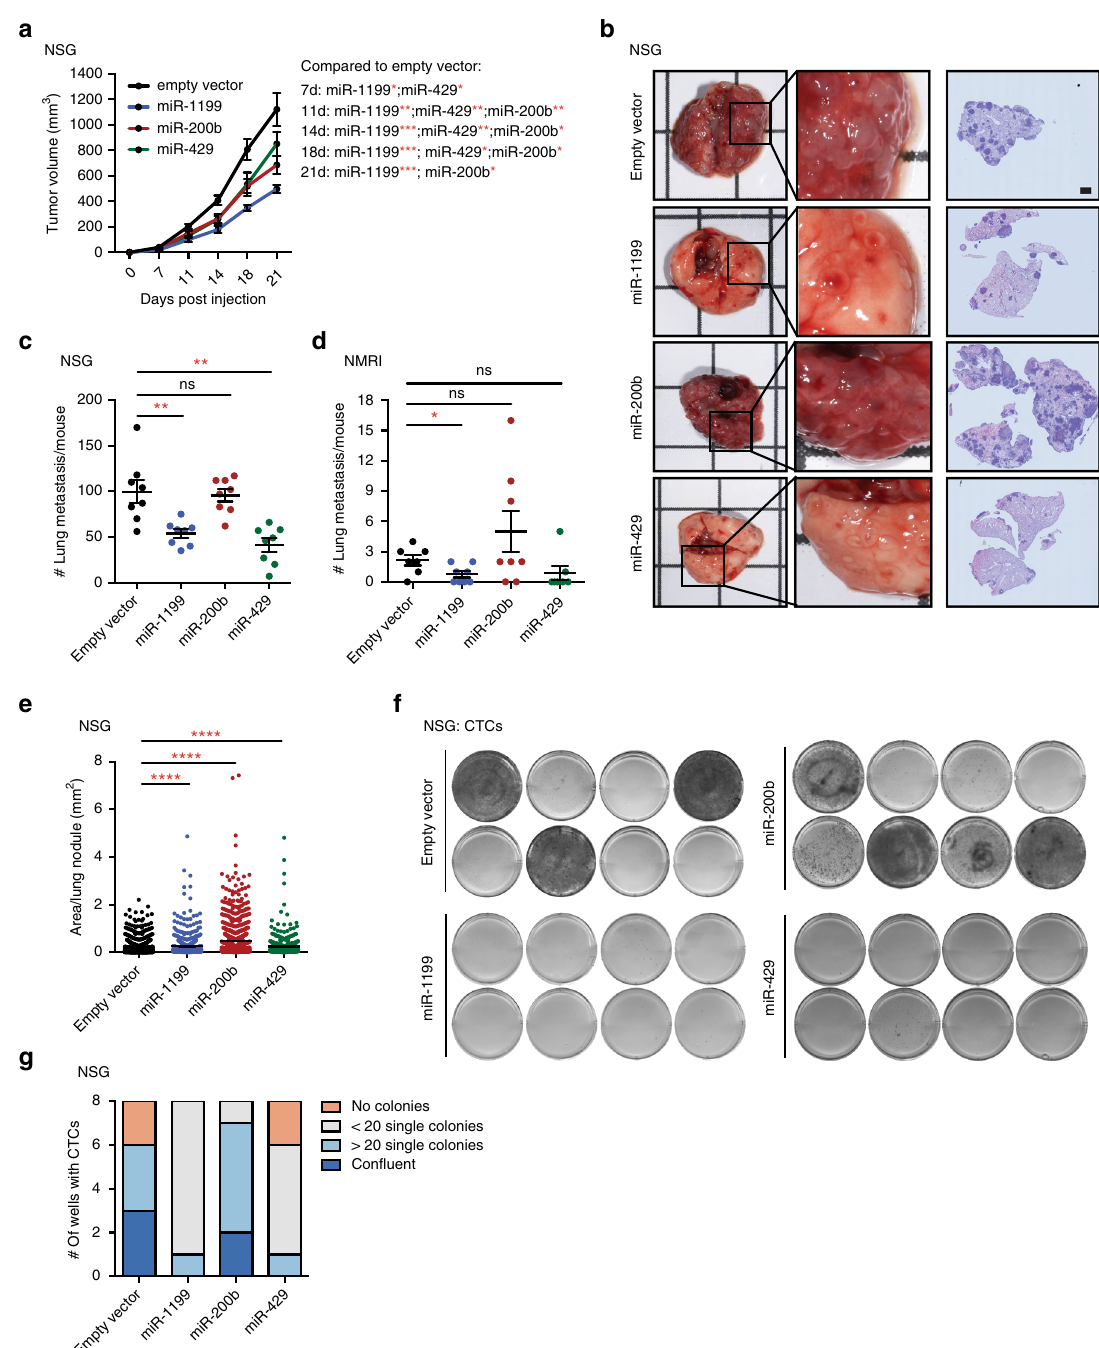
Fig. 6 miR-1199 and miR-200s repress 4T1 murine breast cancer primary tumour growth and metastasis. a ZsGreen-labelled 4T1 cells stably expressing miR-1199, miR-200b or miR-429 were injected into the mammary fat pad of female NSG or NMRI mice as indicated, and primary tumour growth was analysed over time. Statistical signi fi cance compared to empty vector control: 7 days: miR-1199*, miR-429*; 11 days: miR-1199**, miR-429**, miR-200b**; 14 days: miR-1199***, miR-429**, miR-200b**; 18 days: miR-1199***, miR-429***, miR-200b*; 21 days: miR-1199***, miR-200b*. b Representative bright- fi eld images of whole lungs (left), enlargement of indicated lung areas (middle) and H&E staining of lung sections (right) isolated from mice killed 21 days post cell injection. Scale bar, 1 mm. c , d The number of lung metastases per mouse was quanti fi ed microscopically by H&E staining. e The tissue area of all lung nodules was analysed and quanti fi ed microscopically by H&E staining. f , g CTCs isolated from the blood of tumour-bearing mice were isolated 21 days post cell injection and cultured for 5 days ex vivo. Cell colonies were visualized by MTT staining, imaged ( f ) and quanti fi ed ( g ) as indicated. NSG: 8 mice per group ± s.e.m.; NMRI: 7 – 8 mice per group ± s.e.m.; statistical analyses: Mann – Whitney U test; * P < 0.05, ** P < 0.01, *** P < 0.001, **** P <